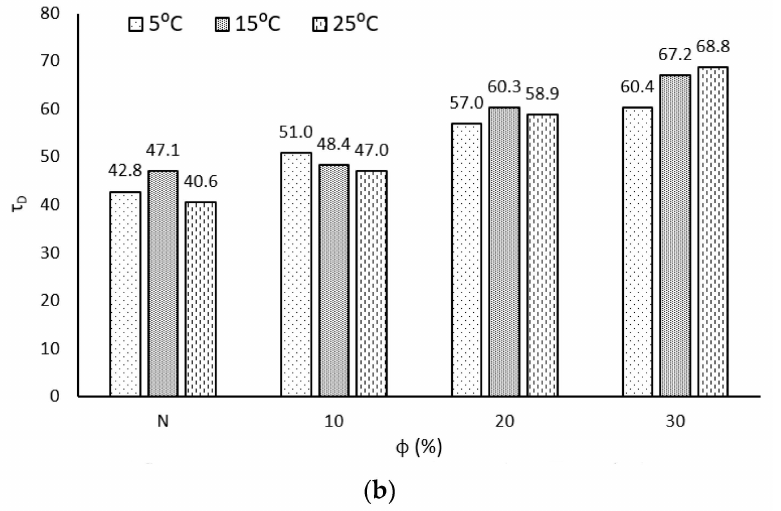
Figure 6. Variation in τ D with the change in ( a ) filler content and ( b ) testing temperature.